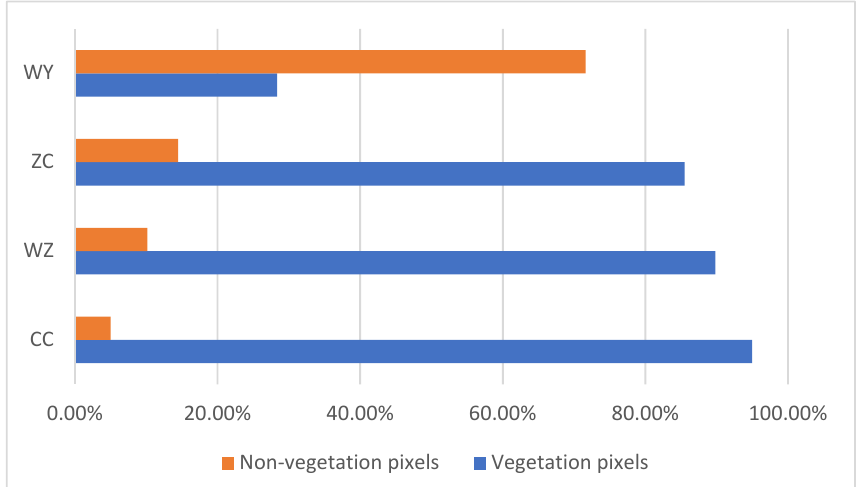
Figure 4. Temperature pie chart of gangue piles.